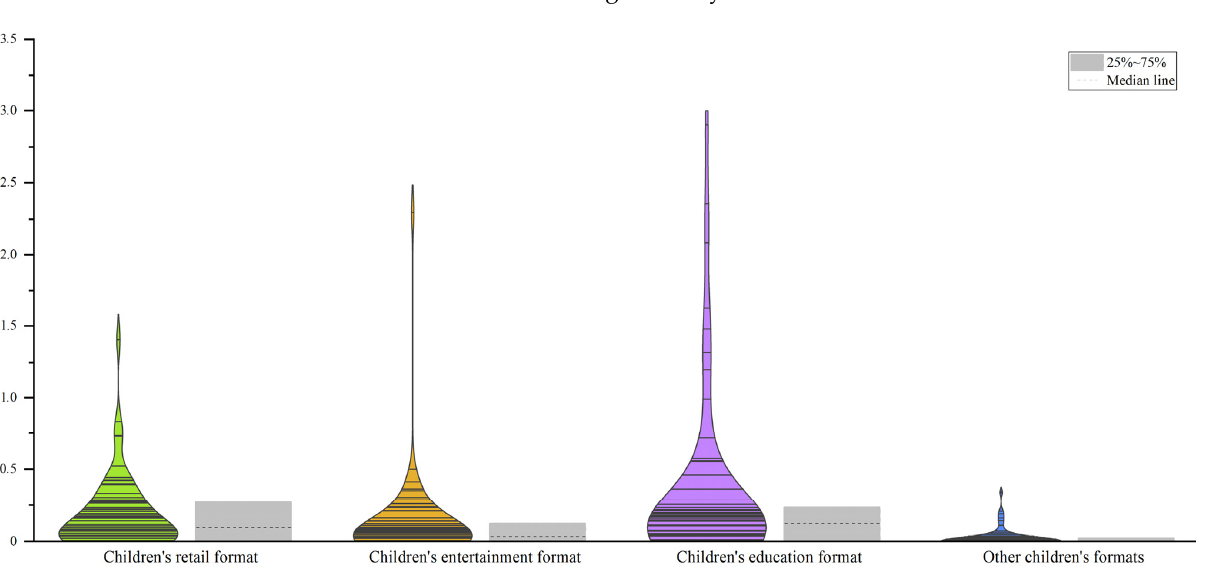
Figure 6. Violin diagram of the clustering degree of various children’s business formats in 66 commercial centers in Wuhan. Data sources: the field investigation data.